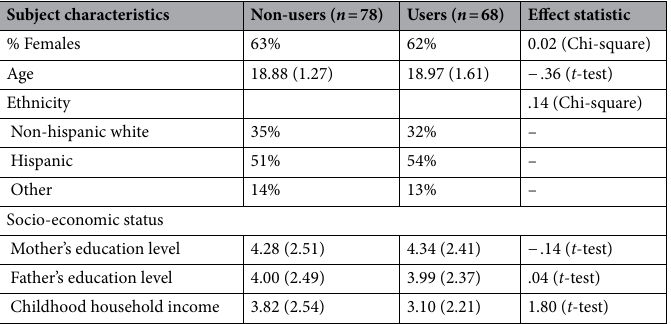
Table 1. Descriptive characteristics of non-users and cannabis users. All group comparisons yielded non- significant differences, p s >